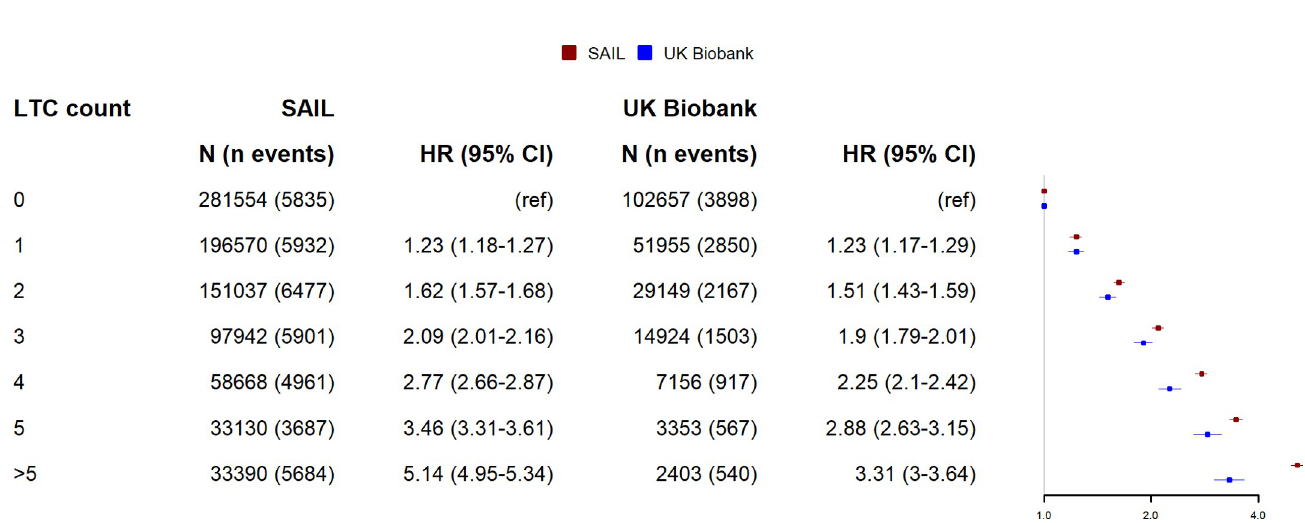
Fig 4. Relationship between LTC count and hazard ratio for mortality in UK Biobank and SAIL. Points indicate hazard ratios adjusted for age, sex, and socioeconomic status. Whiskers indicate 95% CIs. N = total number of participants per LTC count, n events = number of events. CI, confidence interval; HR, hazard ratio; LTC, long-term condition; SAIL, Secure Anonymised Information Linkage.